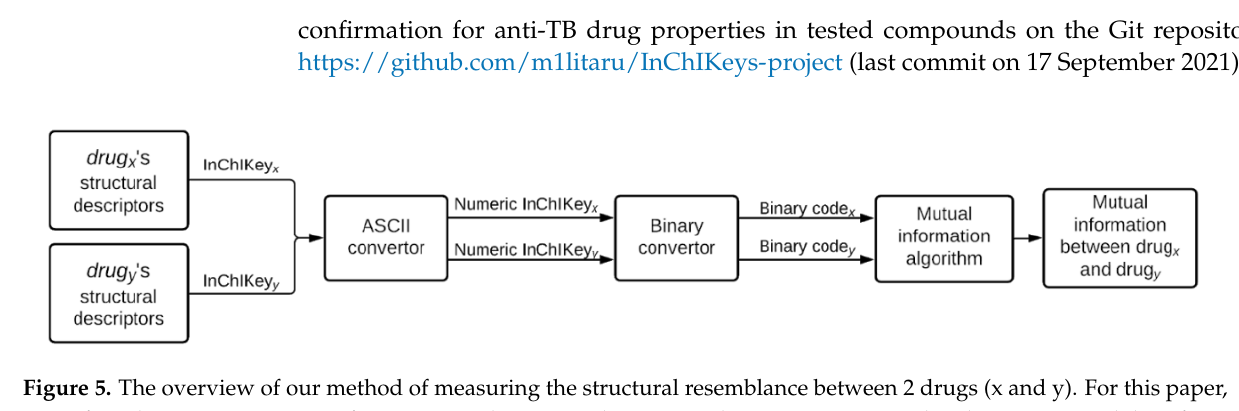
17 of 25 Figure 4. Overview of the machine learning approach: we split the training dataset T (consisting of the reunion of P and N sets) into three subsets, namely Fold 1, Fold 2, and Fold 3. After training a model with an algorithm j with one of the 3 subsets or the entire training set, we obtain a label that we use to compute, for each tested compound i, the final score/label of an algorithm j, the value presented in Table 1 on line i, column j, A(i,j). In the approach presented in Figure 4, the only considered drug features are the 25 letters from the InChIKeys, which we subsequently converted into ASCII integer values. Since the letters A-Z used inside InChIKeys have ASCII values in the 65 – 90 range, we normalized the integers before applying the ML algorithms to avoid biased features. We used the machine learning Python library Scikit-Learn [69,70] (version 0.24.2) for our ensemble method ’ s implementation, involving each of the seven algorithms. 4.2.2. Mutual Information-Based Compound-Drug Similarity Prediction Structural resemblance between the lupane type derivatives, on one hand, and both anti-TB and non-anti-TB drugs-on the other hand, was also determined. As such, we use the ASCII (i.e., integer number) expression of the InChIKey molecular strings to repre- sent chemical structure. Then, we measured the amount of structural information shared by two drug codes as the mutual information [72] between the integer strings corre-